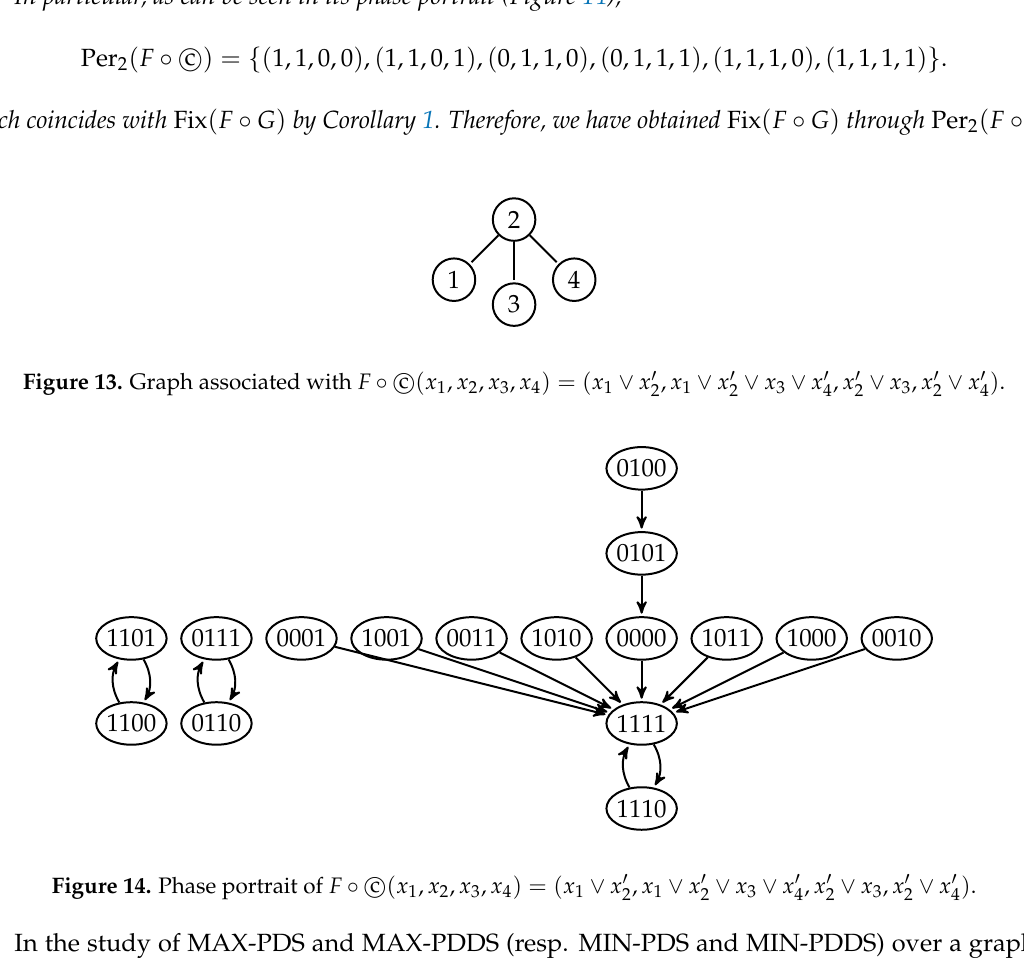
Figure 14. Phase portrait of F ◦ c (cid:13) ( x 1 , x 2 , x 3 , x 4 ) = ( x 1 ∨ x (cid:48)